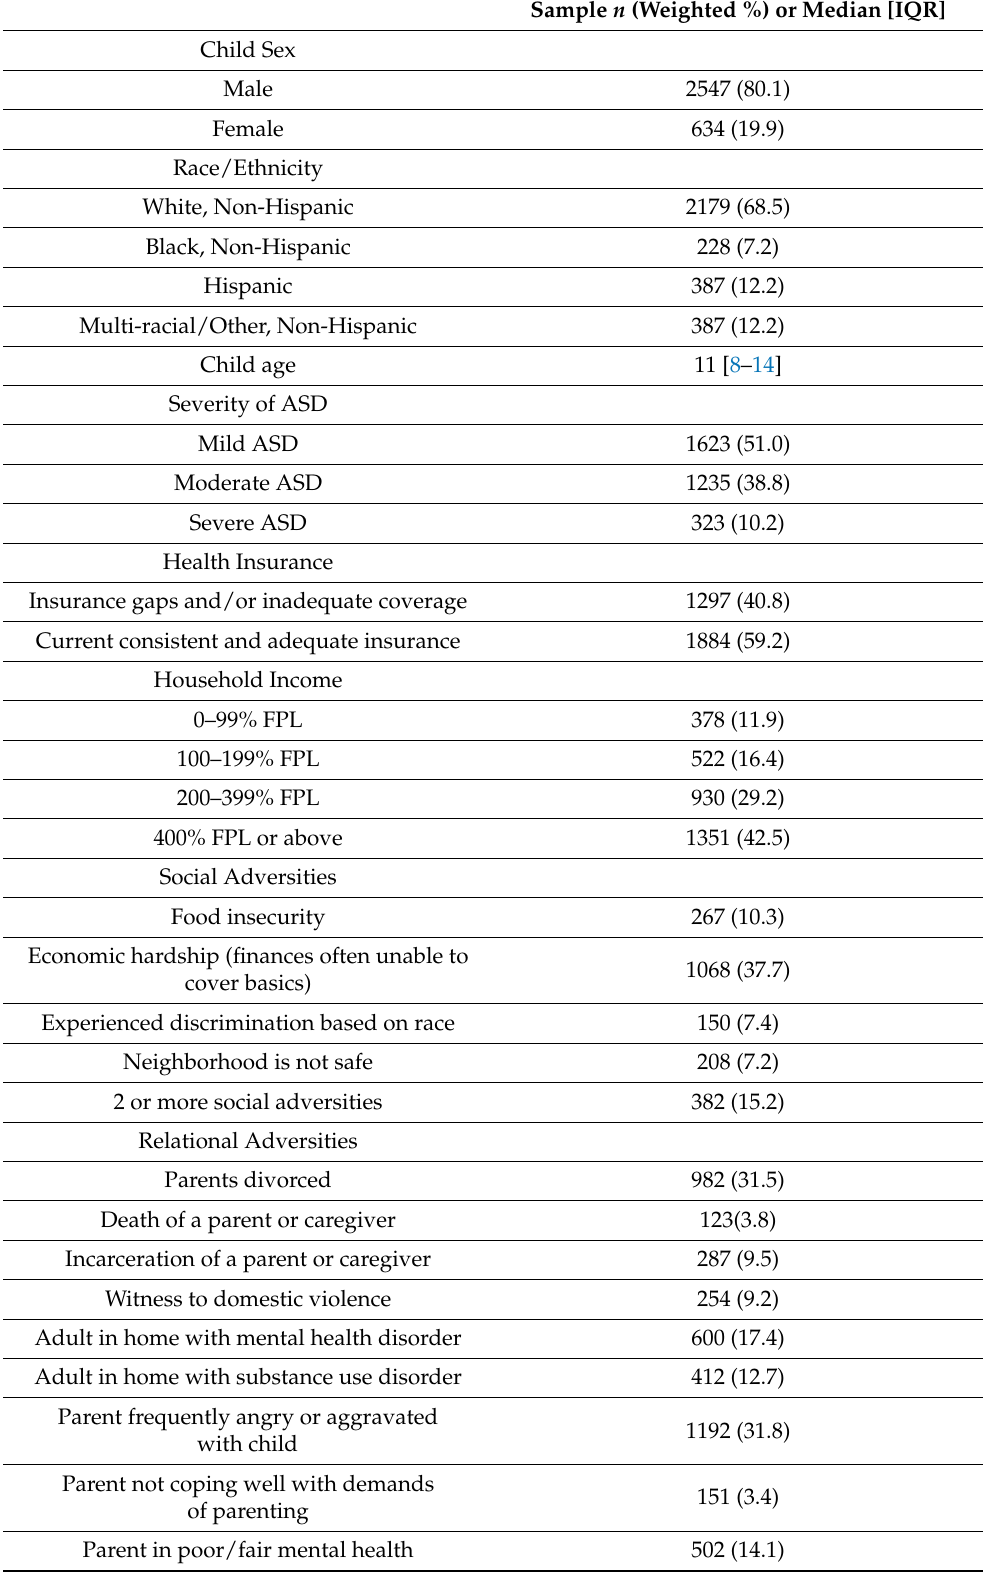
Table 1. Population Characteristics for Multivariable Analytic Sample ( n =